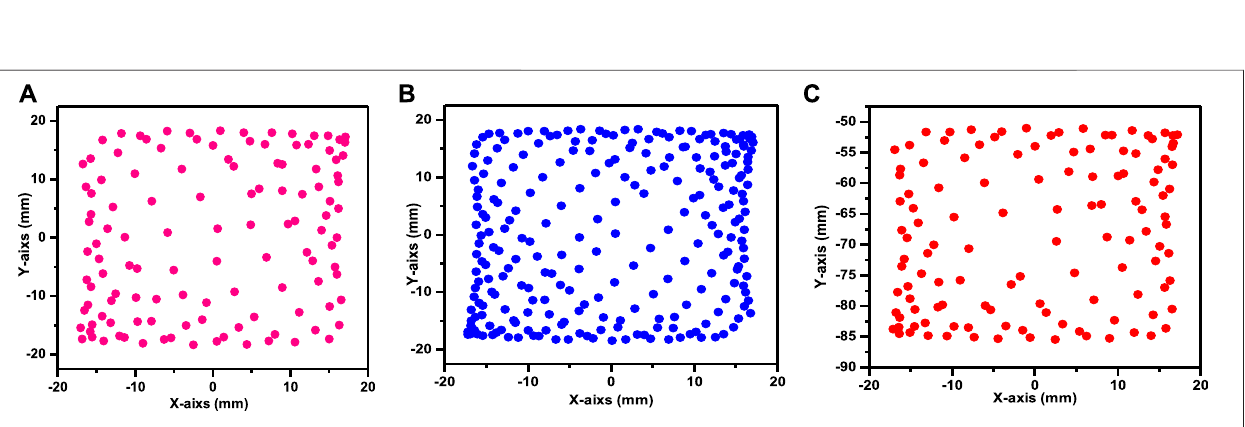
FIGURE 5 | Spot patterns simulated by optical software, (A – C) Spot patterns on spherical mirrors M 1 , M 2 , and M 3 of three different MPCs, respectively. The initial ray parameters for the spot pattern are listed in Table 1 . Pass counts n = 122 times.